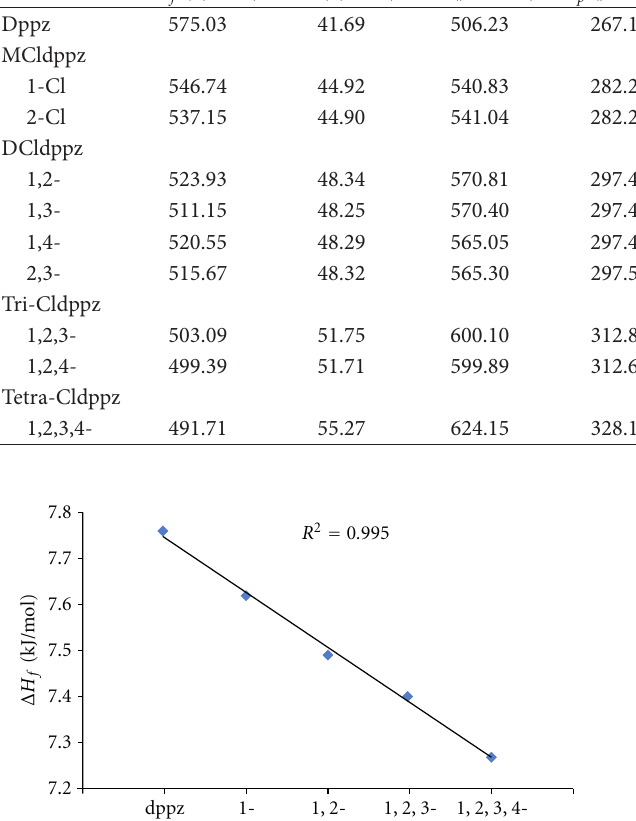
F 4: e plot of for dppz, and 1-, 1,2-, 1,2,3-, and 1,2,3,4- chlorosubstituted dppzs. Δ𝐻𝐻 𝑓𝑓